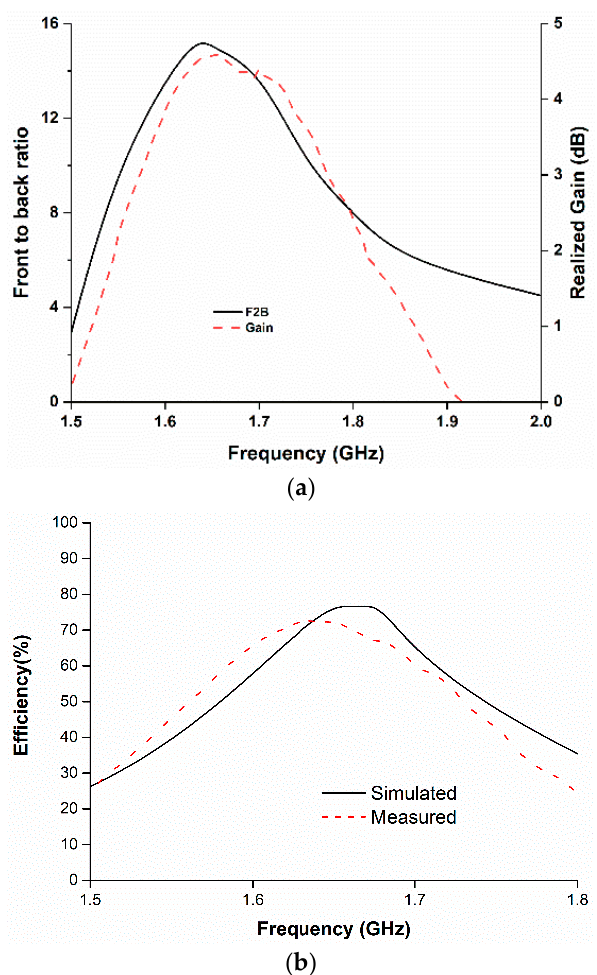
Figure 8. ( a ) Front-to-back ratio and realized gain ( b ) efficiency of the proposed antenna.